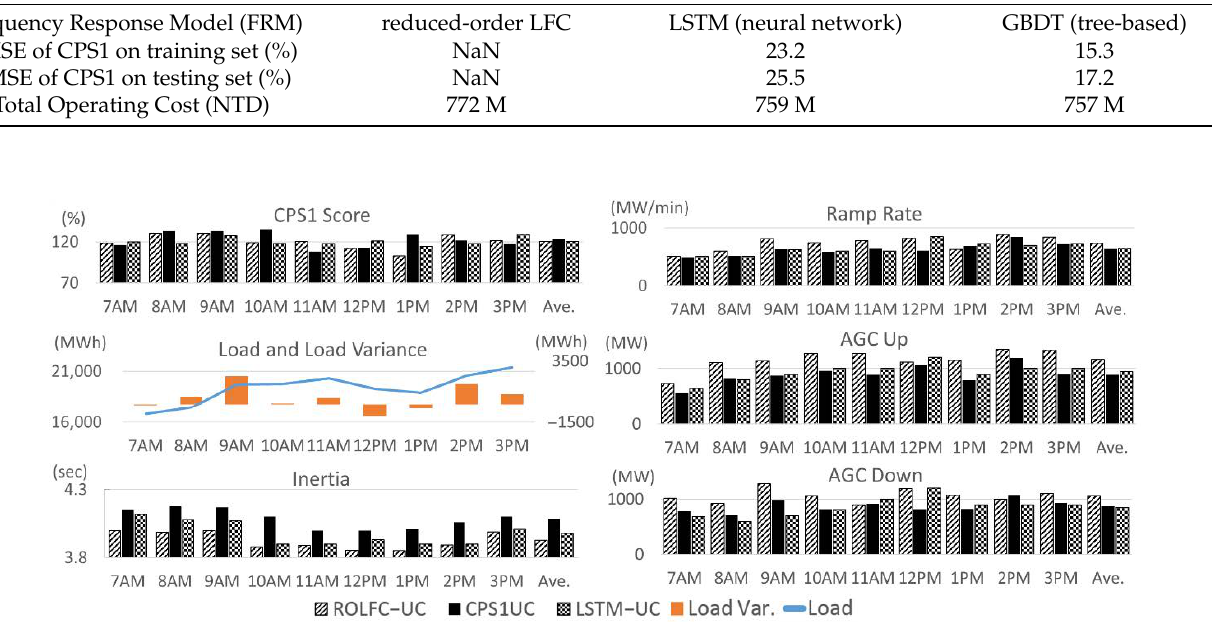
Table 3. Comparisons of scheduling results by three different model-based UCs.